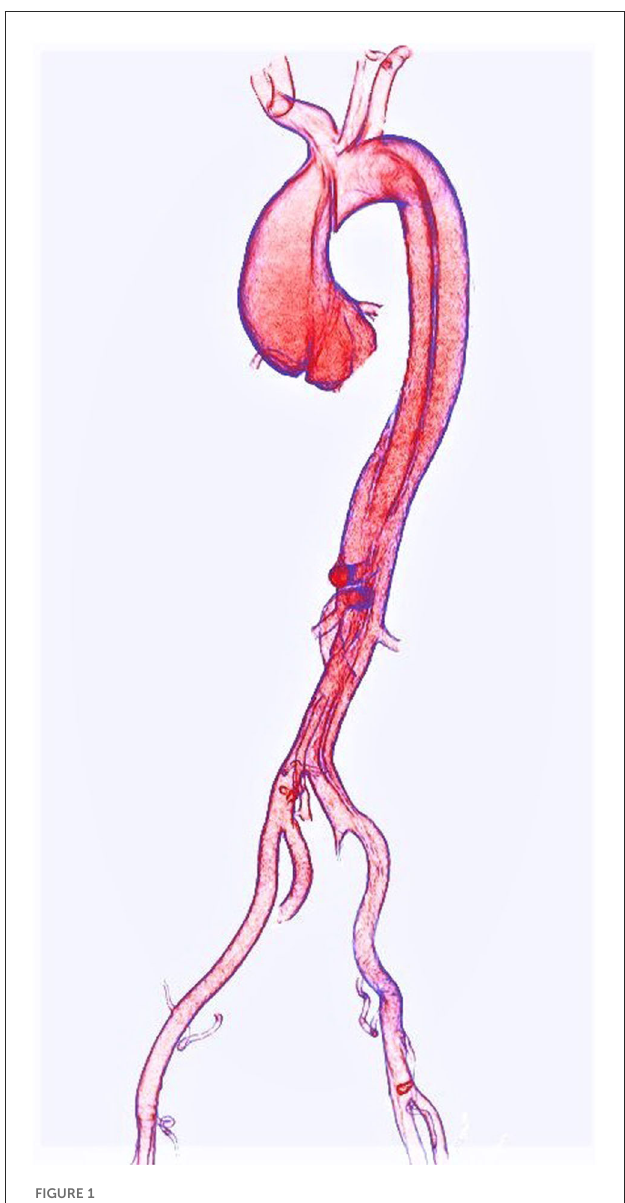
FIGURE1 Volume rendering of an acute Type A aortic dissection as seen on